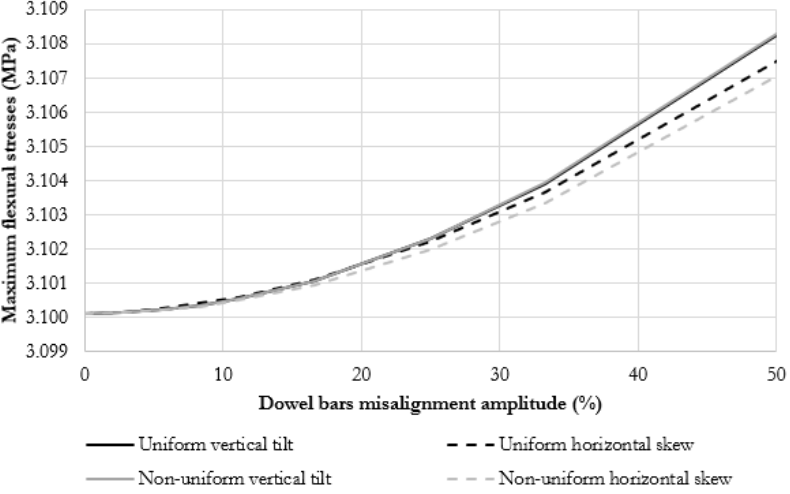
Figure 8. Flexural stresses in concrete slab bonded to cement-treated base for top-bottom thermal differential of 20°C.